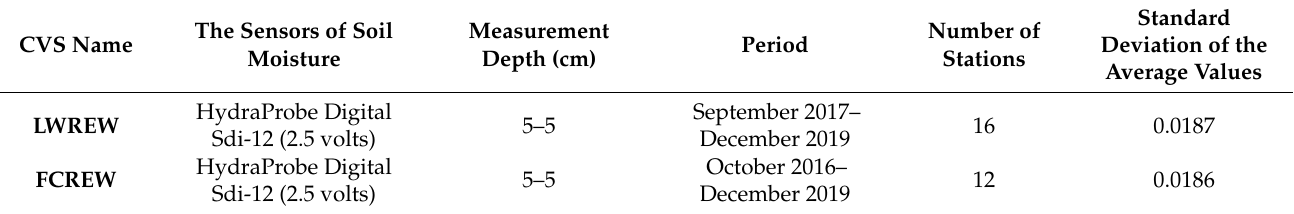
Table 2. Details of the in situ soil moisture data at the study